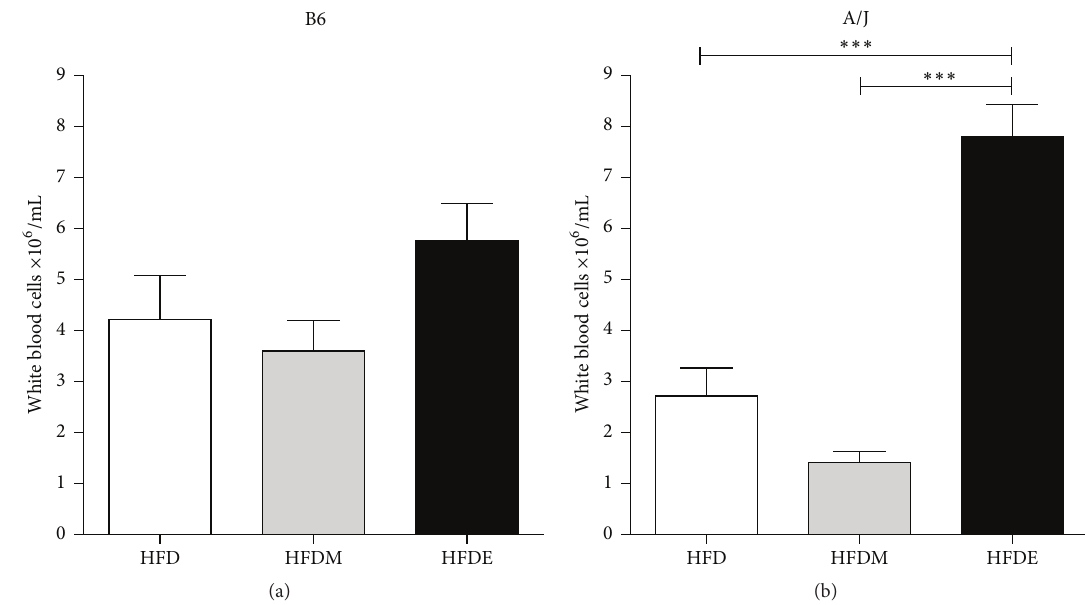
Figure 4: Total number of circulating leukocytes. B6 (a) and A/J (b) mice were fed with HFD, HFDM, or HFDE for 10 weeks. Results from both B6 and A/J mice ( 𝑛 ≥ 5 ) were evaluated by ANOVA one-way and Tukey as a posttest. Values represent means and standard error. The differences are represented by ∗ 𝑃 < 0.05 , ∗∗ 𝑃 < 0.01 , and ∗∗∗ 𝑃 < 0.001 . HFD: high fat diet, HFDM: HFD containing maltodextrin, HFDE: HFD containing ethanol.